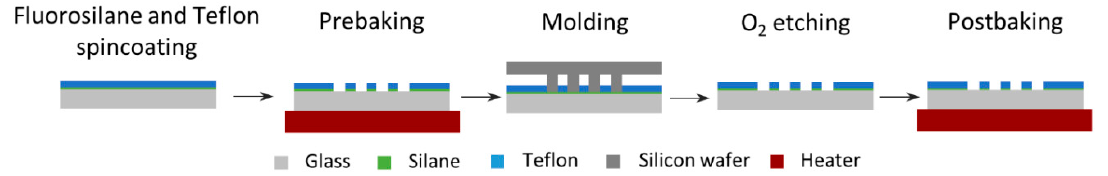
Figure 3. Schematic representation of the microwell array fabrication procedure, including fluoroalkylsilane and Teflon spin-coating, prebaking, molding, O 2 etching and